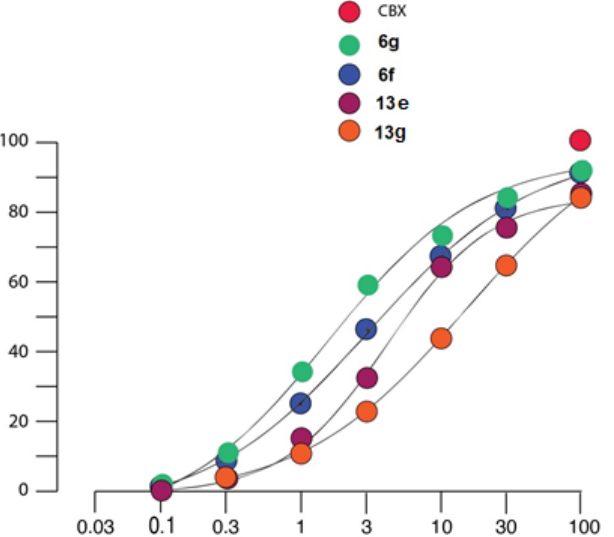
Figure 3. Quantitative analysis of the % inhibition of Panx1-mediated membrane currents in oocytes for compounds 6f , 6g , 13e and 13g . For reference, inhibition by carbenoxolone at 100 µ M, which is known to eliminate membrane currents mediated by Panx-1, was assessed for each oocyte at the end of each experiment after the test compounds induced inhibition.